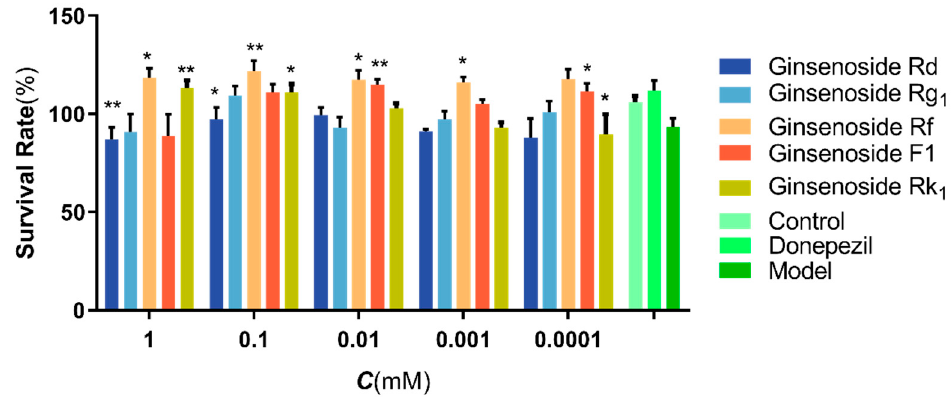
Figure 8. Effects of five active compounds in SH-SY5Y cells induced by H 2 O 2 . The data are presented as the means ± SEM (n = 3) *: p < 0.05 compared with the model group, **: p < 0.01 compared with the model group.